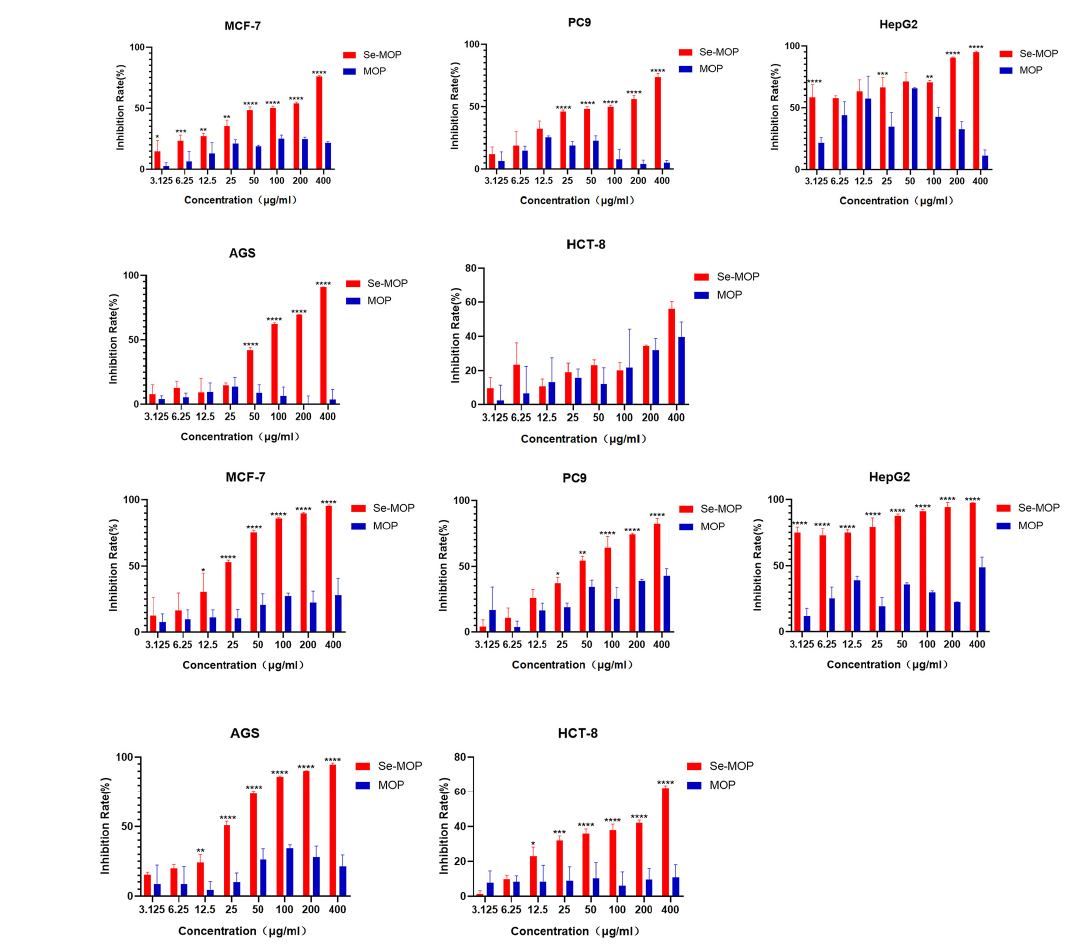
Figure 5. Inhibition rates of Se-MOP and MOP by CCK8 assay on human cancer cells after 48 h ( A ) and 72 h incubation ( B ). ( A ) Inhibition rate of Se-MOP and MOP (3.125, 6.25, 12.5, 25, 50, 100, 200, and 400 µ g/mL) on MCF-7 cells, PC9 cells, HepG2 cells, AGS cells, and HCT-8 cells after 48 h incubation. ( B ) Inhibition rate of Se-MOP and MOP (3.125, 6.25, 12.5, 25, 50, 100, 200, and 400 µ g/mL) on MCF-7 cells, PC9 cells, HepG2 cells, AGS cells, and HCT-8 cells after 72 h incubation. Data from three separate experiments are expressed as means ± SD in triplicate. * p < 0.05, ** p < 0.01, *** p < 0.001, **** p < 0.0001 vs. the control group.